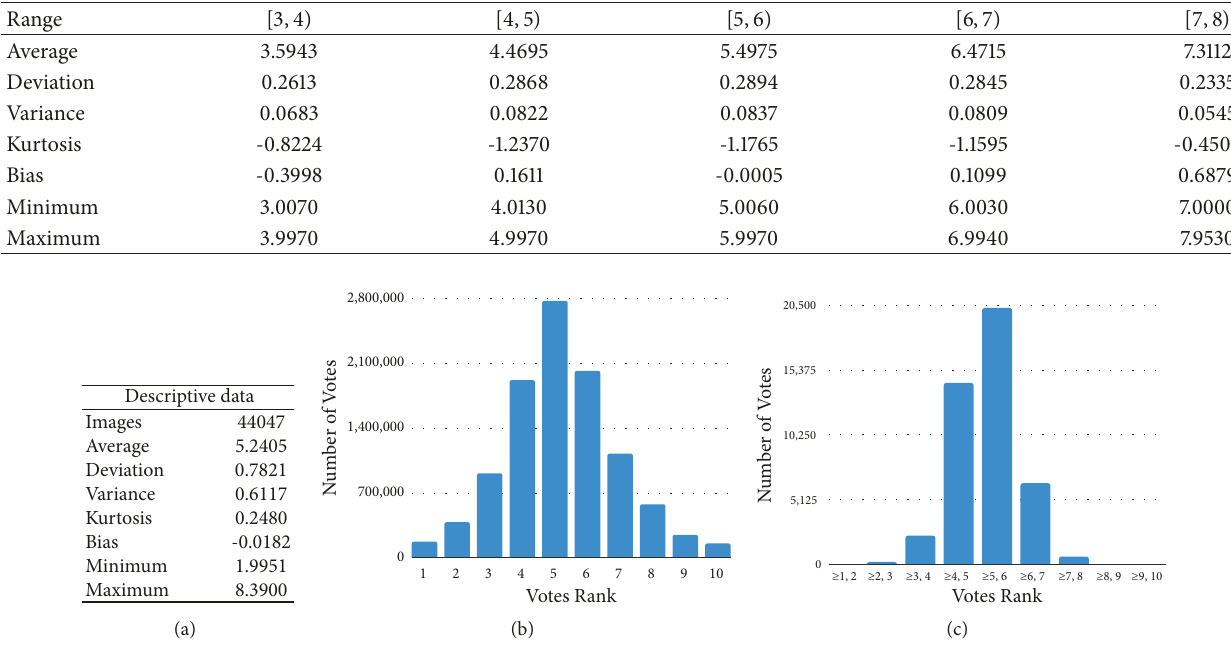
scores and (b) the distribution of the mean ratings within the range of valid scores for the 1000-image